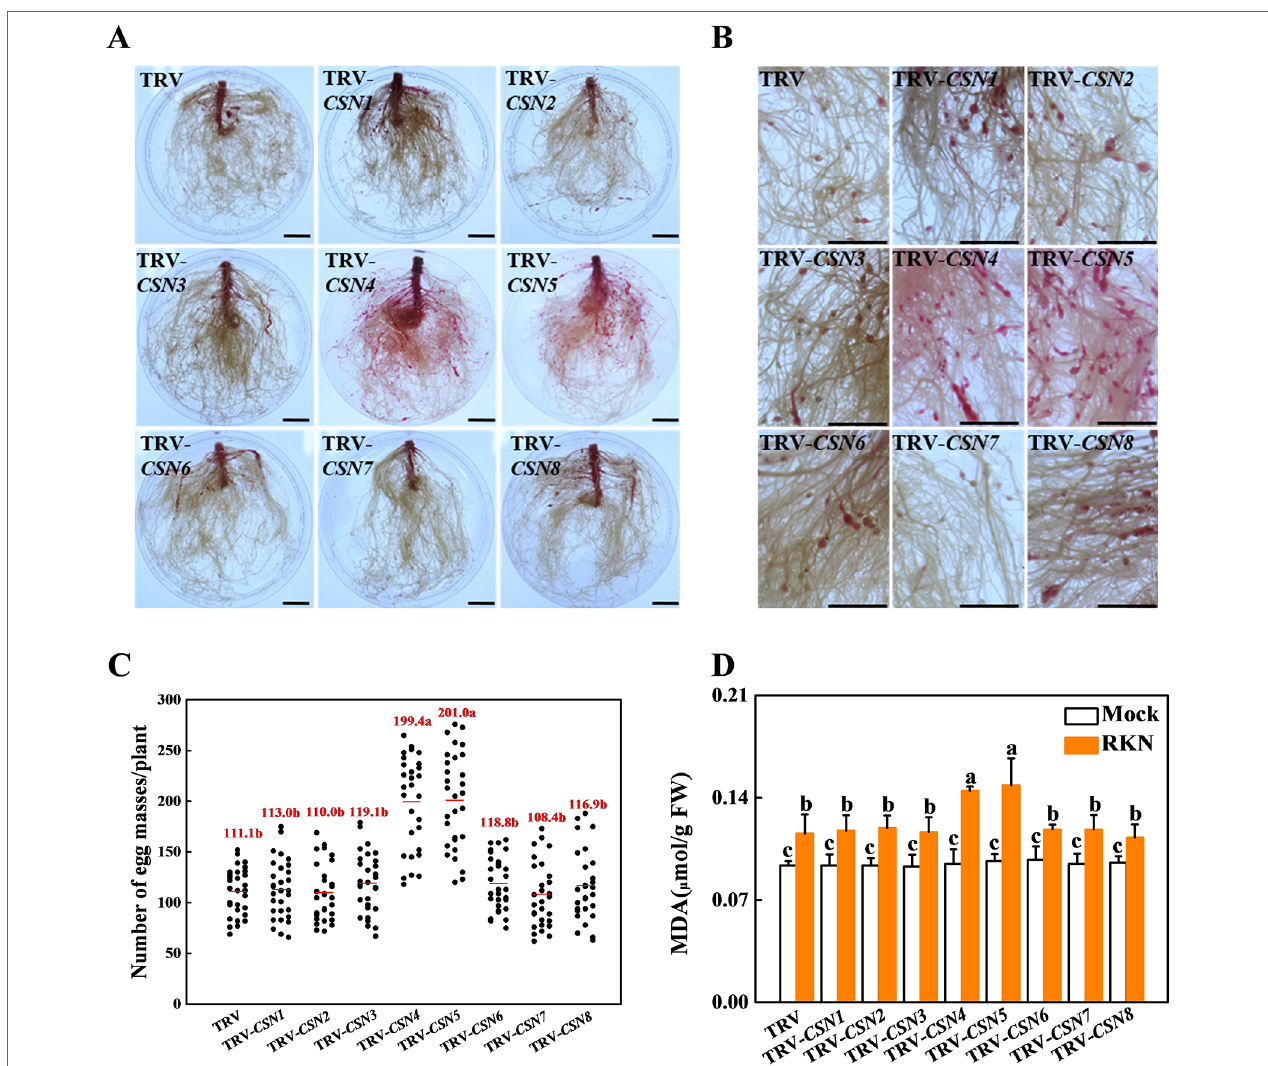
FIGURE 3 | Characterization of the COP9 signalosome ( CSN )-silenced tomato lines against root-knot nematodes (RKNs). (A and B) Phenotype of RKN reproduction in different virus-induced CSN gene-silencing plants using acid fuchsin staining 4 weeks after RKN infection. Bars = 2 cm. (C) The number of egg masses on the roots at 4 weeks after infection with Meloidogyne incognita . The red number is the average number of egg masses per plant. Thirty plants per genotype were used in each experiment. Three independent experiments were performed with similar results. (D) Lipid peroxidation was estimated by measuring the content of malondialdehyde (MDA) in the roots at 4 weeks after infection with M. incognita . The data shown are the average of three biological replicates, with the standard errors shown by vertical bars. Means denoted by the same letter did not significantly differ at P < 0.05, according to Tukey’s